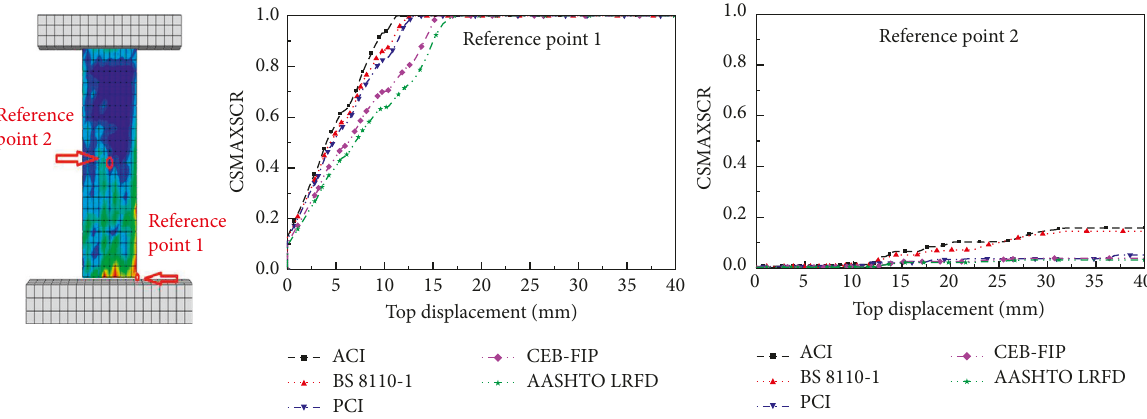
Figure 22: CSMAXSCR-top displacement curves of W2 under 0.3 axial compression